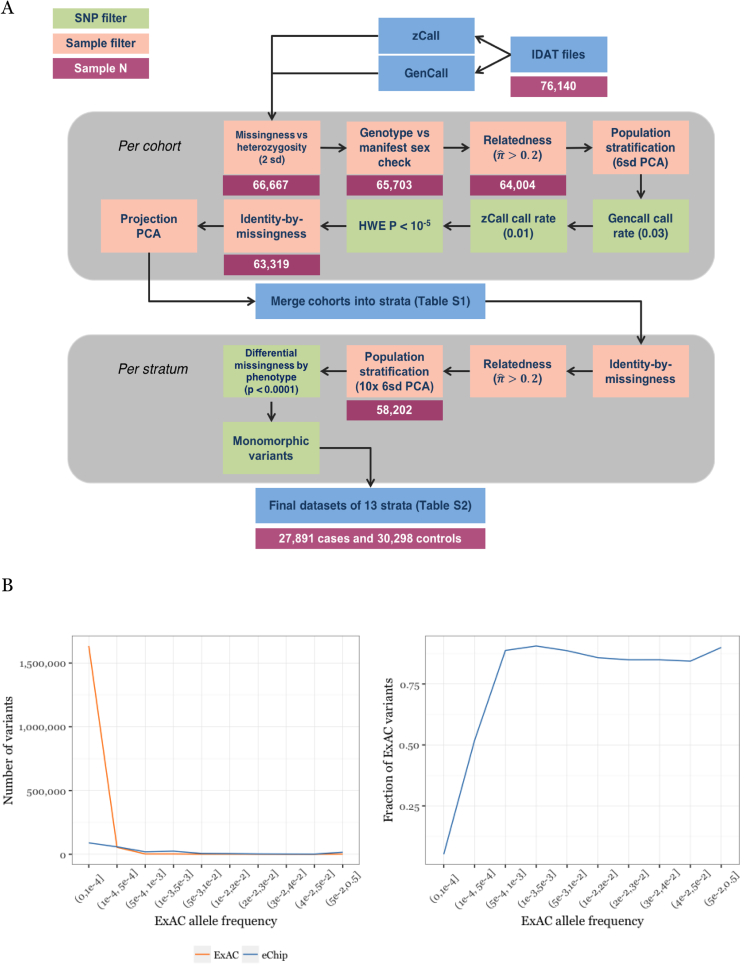
Data Quality Overview, Related to STAR Methods(A) QC process. We assembled 42 cohorts of data (either entire country-level collections or groups of samples processed as a batch; Table S1). We called common variant genotypes with the standard algorithm provided by Illumina (GenCall), and low-frequency variants with zCall, an algorithm specifically developed to call these variants on the exome chip (Goldstein et al., 2012). We performed initial quality control on each cohort separately to account for variation between batches and cohorts (upper gray region), then merged cohorts into 13 country-level strata. To ensure that these strata were uniform we then performed stringent quality control on each stratum (lower gray region) to produce our final dataset.(B) the exome chip captures a large fraction of ExAC (release version 1) low-frequency miss-sense variants. The exome chip captures the majority of variants present in ExAC (Lek et al., 2016) down to a minor allele frequency ∼0.0005, below which a large number of variants is observed (left). Thus, the overall coverage at very rare alleles (5 × 10−4 > MAF > 1.5 × 10−5, corresponding to a single allele seen in 33,370 non-Finnish European individuals in ExAC) is low (right).